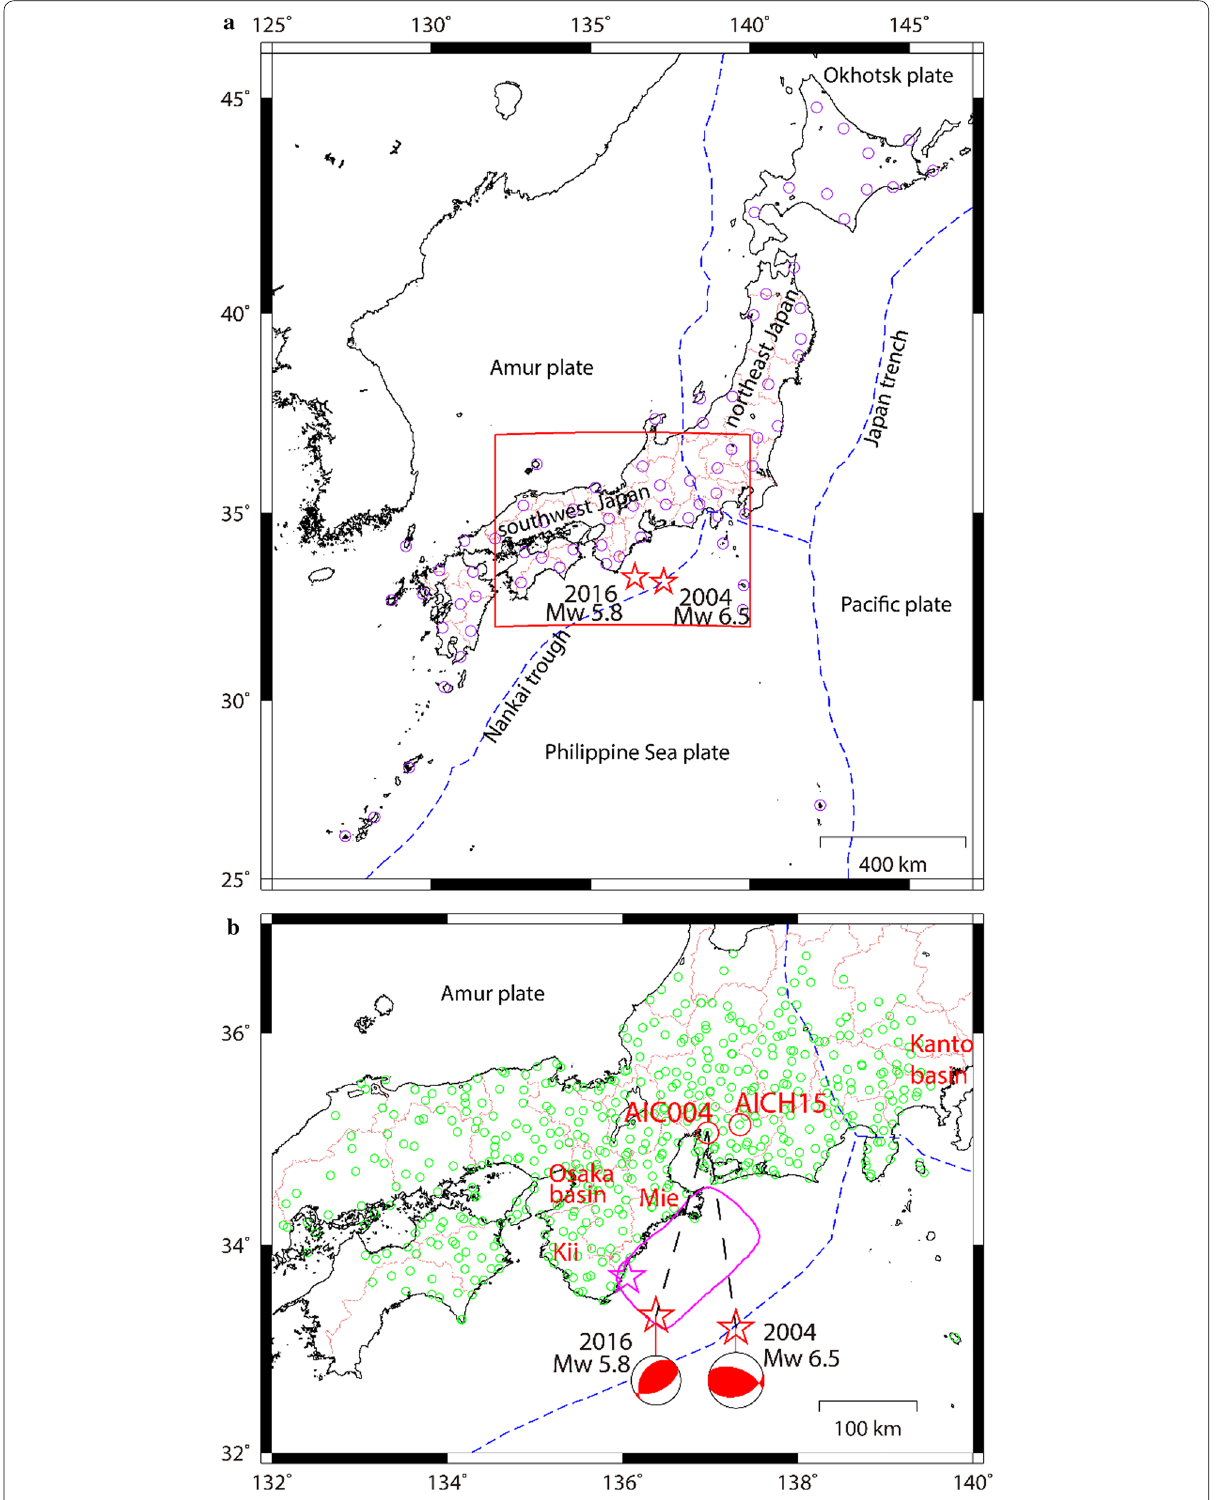
Fig. 1 Index maps. a The red stars denote the epicenters of the 2004 Mw 6.5 and 2016 Mw 5.8 earthquakes. The red rectangle denotes the boundary of the enlarged map shown in b . The purple circles denote the broadband stations used in the paper. b The magenta star and rectangular area denote the epicenter and boundary of the fault model of the 1944 Tonankai earthquake (Kikuchi et al. 2003). Green circles denote the strong-motion stations used in the paper. The black dashed lines denote the surface lines for velocity profiles plotted in Fig.